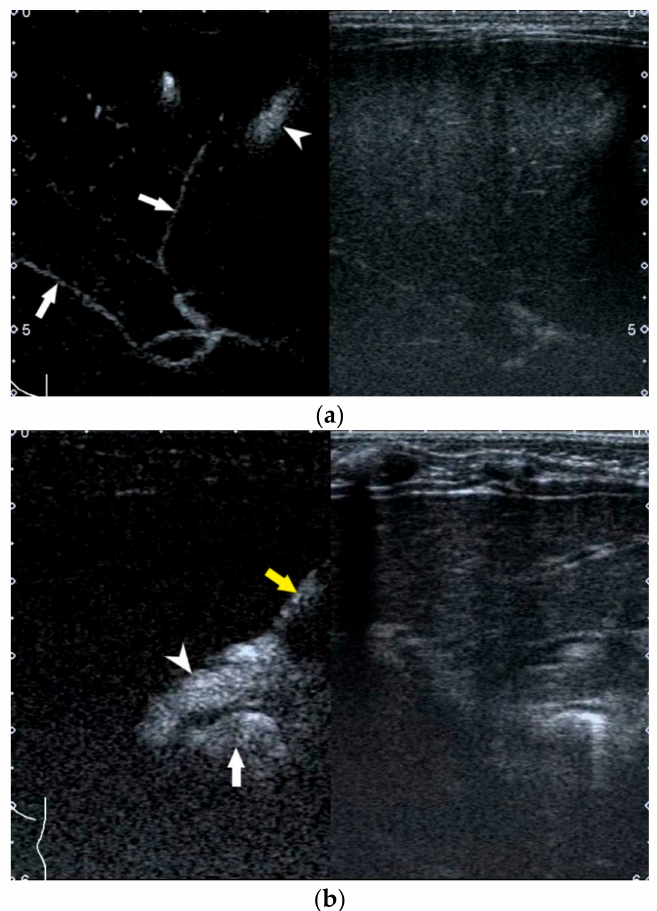
Figure 8. Image obtained at US-guided percutaneous cholecystocholangiography with microbubbles. ( a ) Gallbladder is filled with contrast material (arrowhead) and contrast material flows into intra- hepatic bile ducts (arrows) in an infant without BA. ( b ) Contrast material flows along the puncture needle (yellow arrow) into the gallbladder (white arrowhead) and then into bowel (white arrow) in an infant with BA. No contrast material flows into the intrahepatic bile